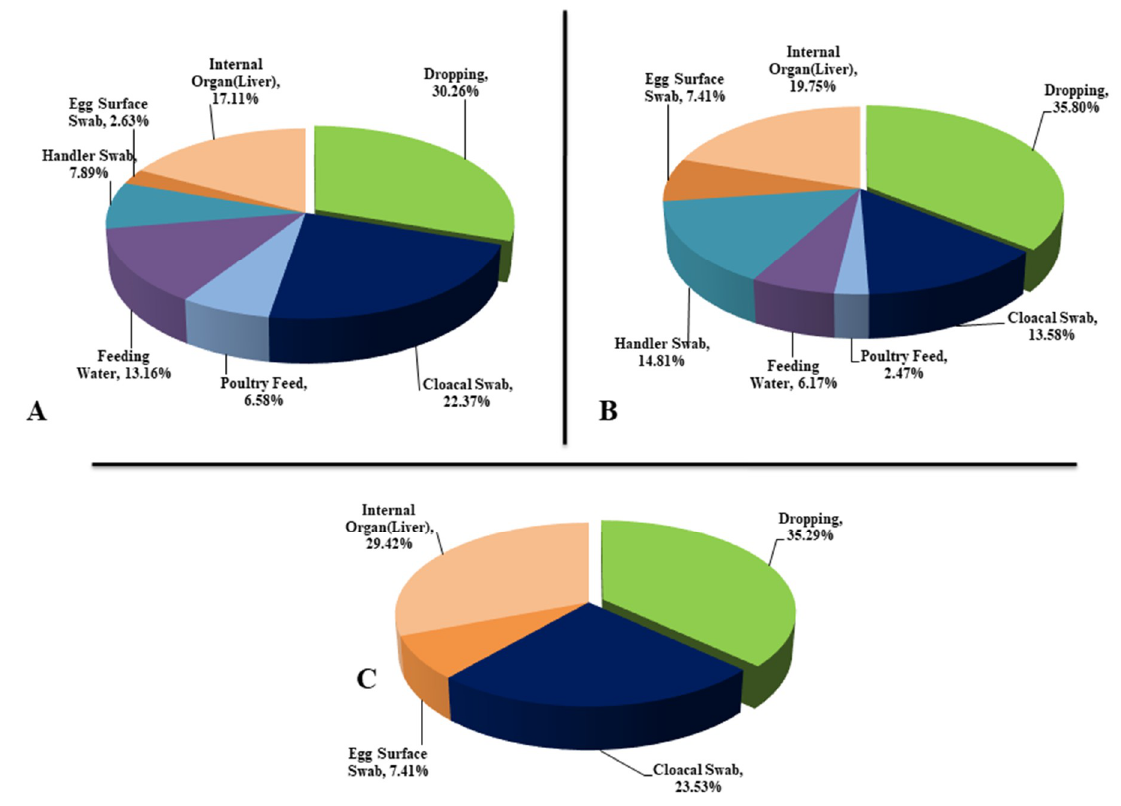
Figure 1. Prevalence of avian pathogenic Escherichia coli (APEC) in different types of poultry samples. Microorganisms identified in different types of avian samples belonged to different locations: ( A ) (Dhamrai, Manikgonj); ( B ) (Rupganj, Narayangonj); and ( C ) (Monohardi, Narshingdi). The Dhamrai, Rupganj and Monohardi regions included 76, 81, and 17 isolates, respectively.